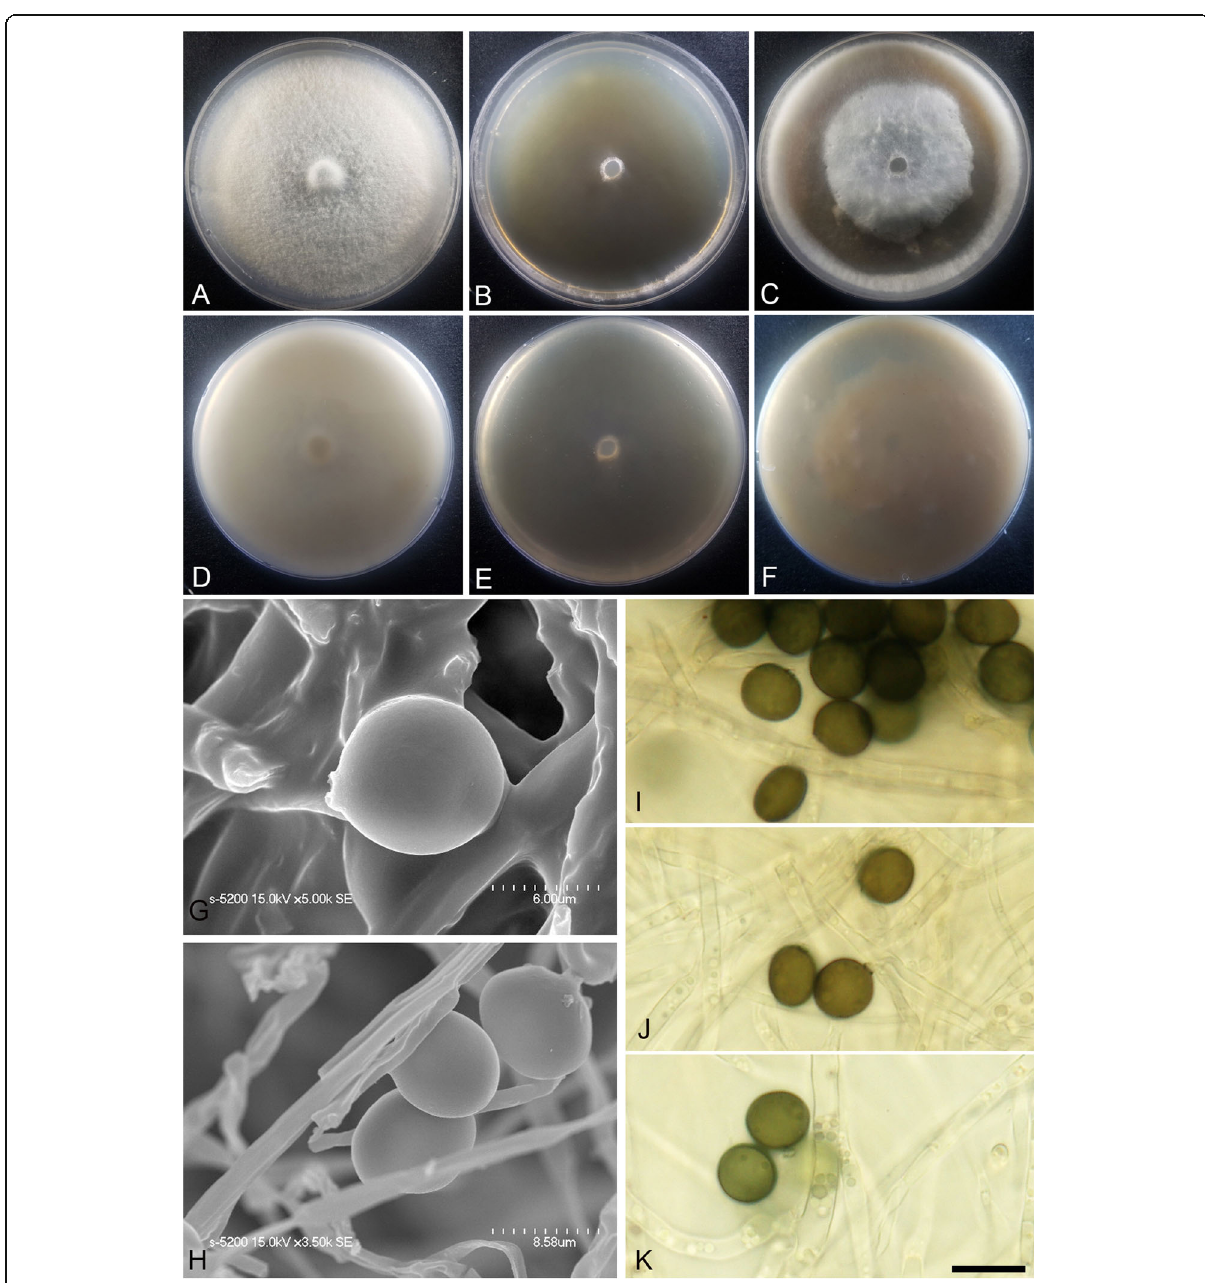
Fig. 3 Arthrinium agari (KUC21333). a-c Colonies on PDA ( a ), MEA ( b ), and OA ( c ) (top); d-f , colonies on PDA ( d ), MEA ( e ), and OA ( f ) (bottom); g-h , conidia under SEM; i-k , conidia attached to conidiogenous cells; scale bar = 10 μ